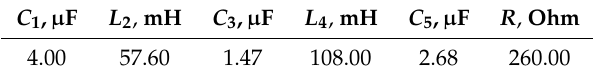
Table 1. Elements values of the passive filter.